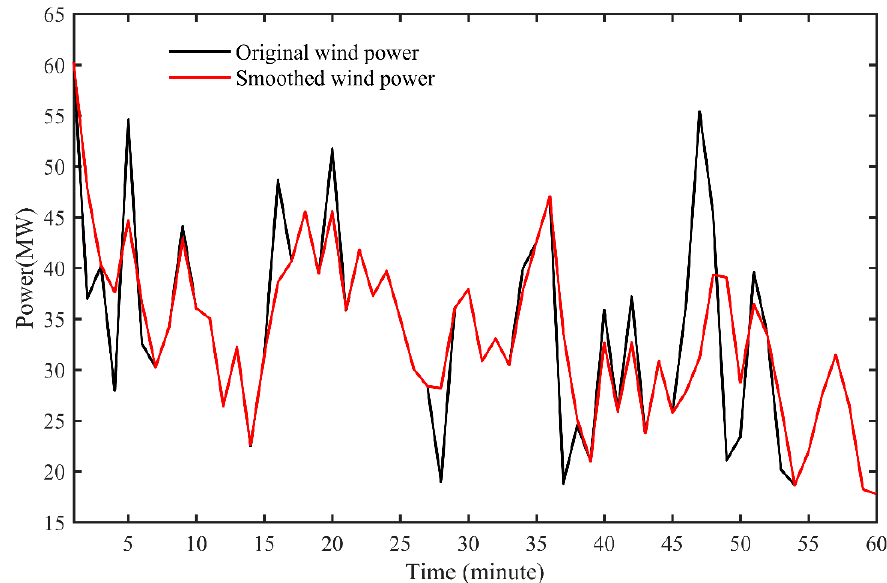
Figure 9. Second validation result of the BESS performance.